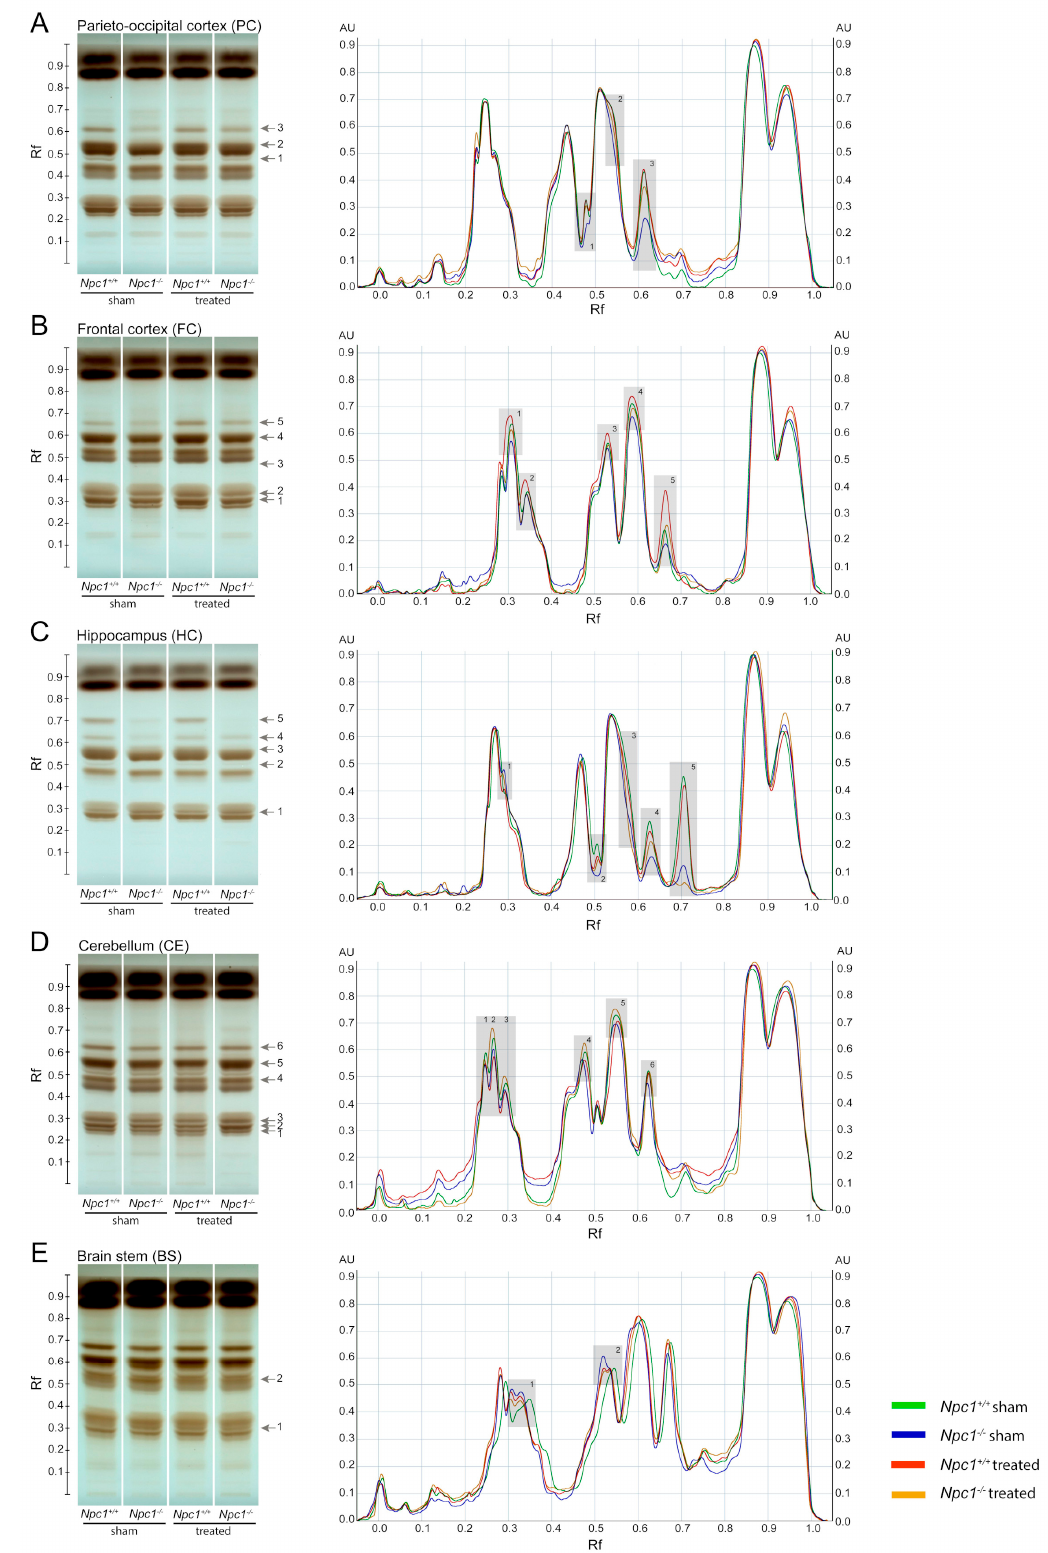
Figure 1. HPTLC (High-performance thin-layer chromatography) analysis from different brain tissues of sham-treated and treated Npc1 +/+ and Npc1 − / − mice ( A – E , all groups n = 3). HPTLC images visualized the differences of phospho- and sphingolipid amounts in the four different groups. Changed lipid classes were marked with gray arrows, corresponding to the gray boxes also shown in the digital scanning profile. Band intensities of the separated lipids were calibrated in arbitrary units (AU), representing the relative absorbance. The retention factor (Rf) represents the relative distance